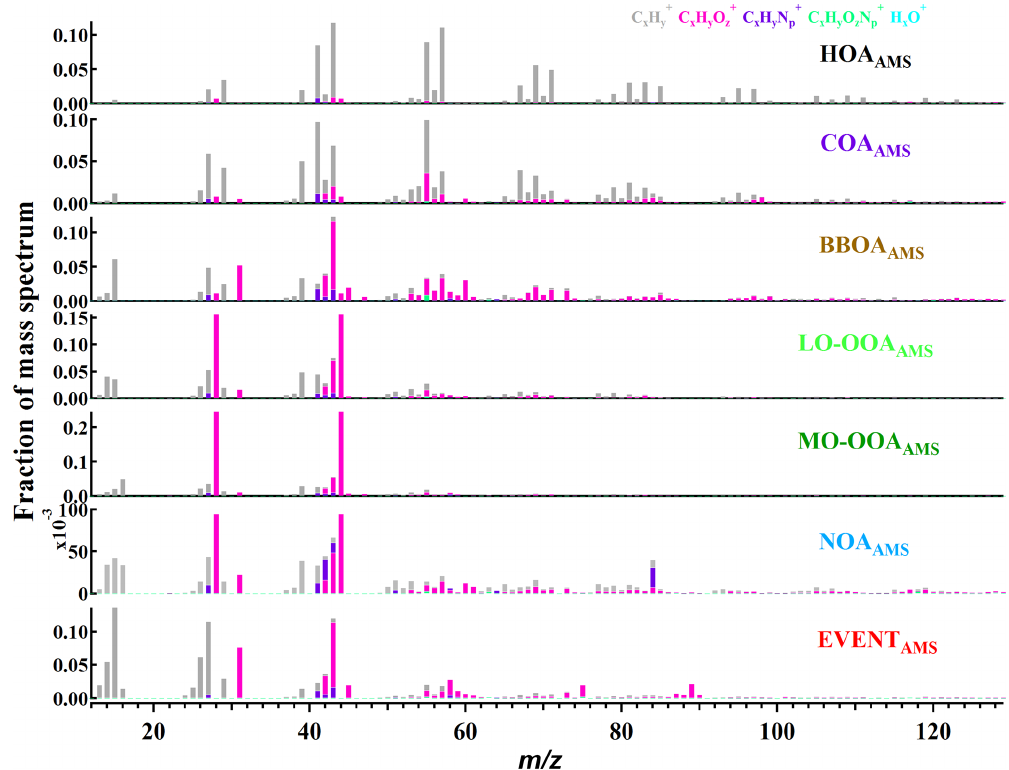
Figure 1. Factor profiles for the seven-factor AMS PMF solution. HOA AMS is constrained by an a value of 0.1. The total signal of each factor is normalized to unity (HOA AMS : hydrocarbon OA; COA AMS : cooking-related OA; BBOA AMS : biomass burning OA; OOA AMS : oxygenated OA; NOA AMS : nitrogen-containing OA; EVENT AMS , an isolated local